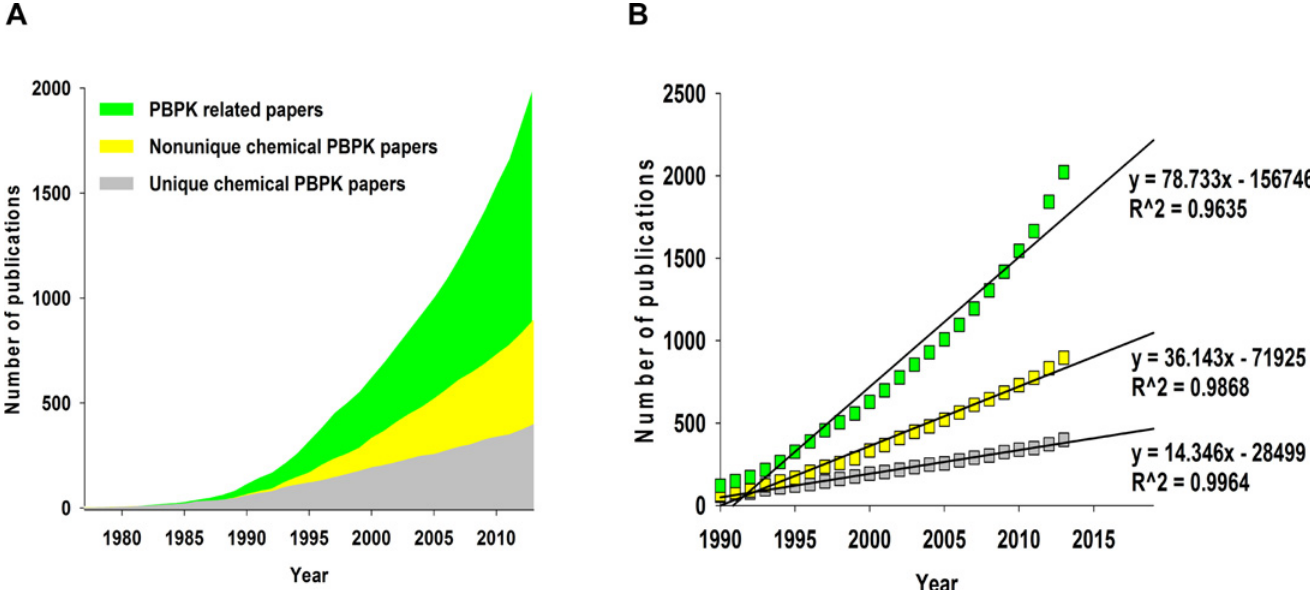
Fig 1. Trends of PBPK literatures. (A) The 2,039 PBPK-related articles are placed into one of three categories: (1) unique chemical PBPK papers (grey), pioneering articles in which specific chemical names have appeared for the first time; (2) non-unique chemical PBPK papers (yellow), articles in which chemical names have appeared in previous publications; or (3) PBPK related papers (green), articles that are not associated with specific chemical names. (B) Linear regression of the number of articles in three categories over time.